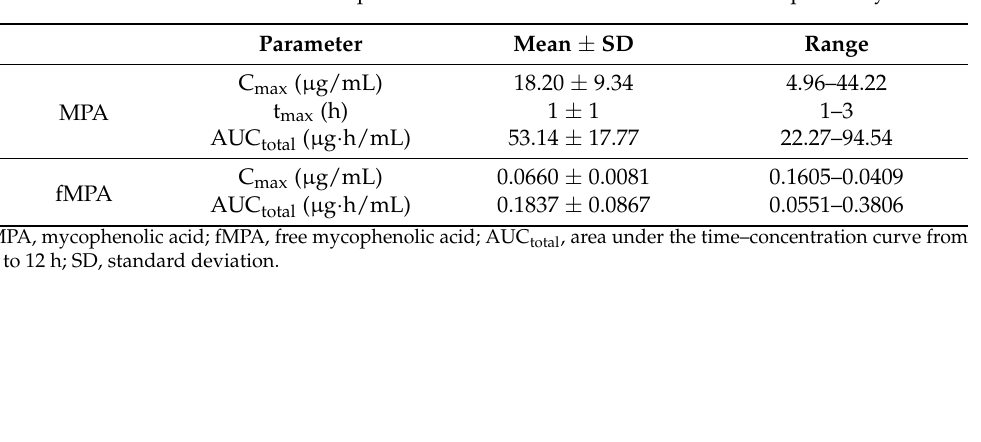
Table 1. Plasma concentrations and exposure of MPA and fMPA in children with nephrotic